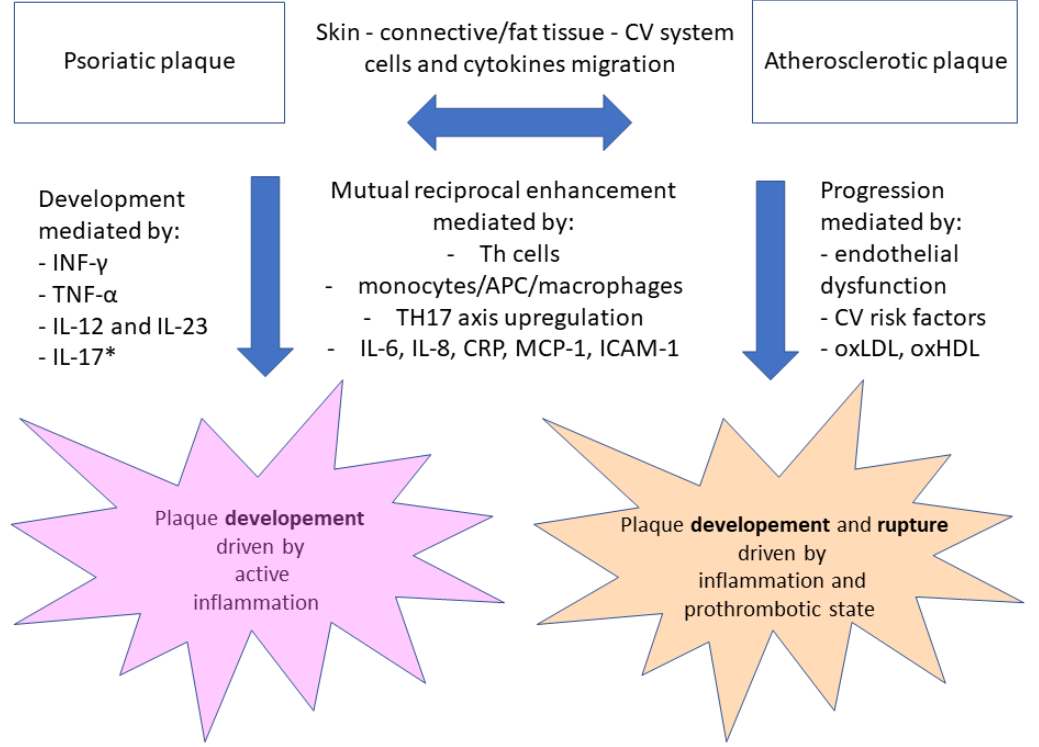
Figure 1. Interconnection between PSO and Ath—two plaques’ interactions. Notes: IL-12 and IL-2—interleukins sharing common p40 subunit, IL-17*—interleukin with potential pro- and anti-atherosclerotic activity in PSO plaque stimulates hyperproliferation and differentiation of keratinocytes, maturation of dendritic cells and recruitment of neutrophils and macrophages in psoriatic lesions. Abbreviations: CV—cardiovascular, INF-γ—interferon gamma, TNF-α—tumor necrosis factor alfa, IL—interleukin, APC—antigen presenting cell, CRP—C-reactive protein, MCP-1—monocyte chemoattractant protein-1, ICAM-1—intracellular adhesion molecule-1, oxLDL—oxidized low-density lipoprotein, oxHDL—oxidized high-density